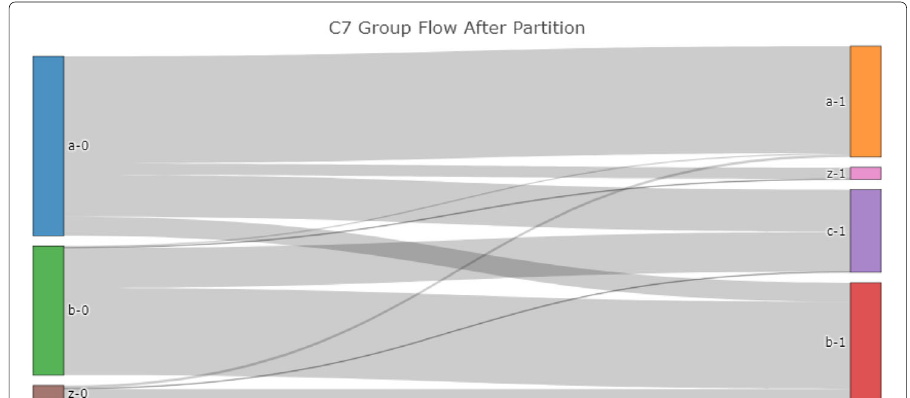
Fig. 3 Sankey visualization of the flow from Rada groups in time segment 1 to time segment 2. Groups in the “z” category are isolate nodes that were lumped together for convenience. The main finding here is the birth of a third group, which drains the controlling faction of its majority, giving the opposing faction the most power after the revolution